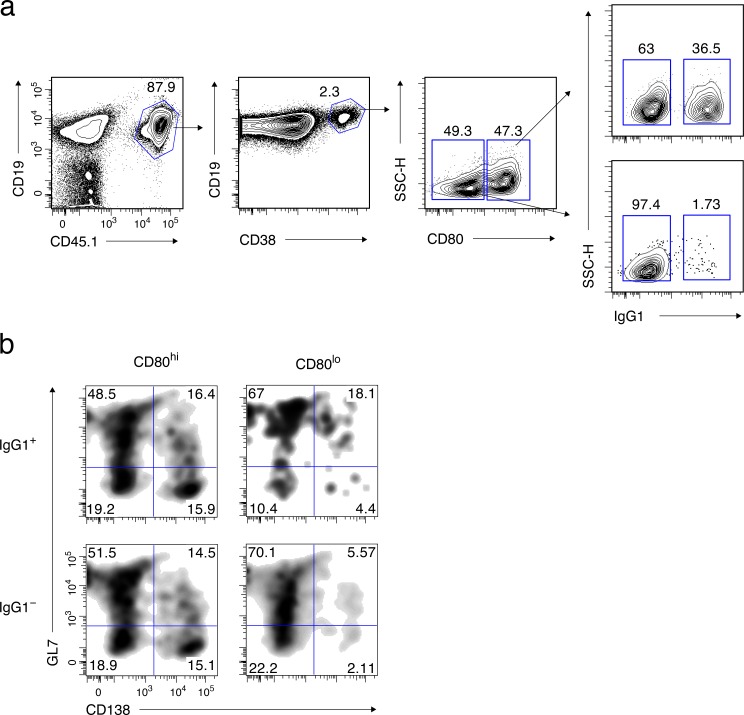
Supplementary data for Figure 1.(a) Sorting strategy for Figure 1b. Splenic B cell from CD45.1 B1-8 ki mice were transferred into B6 mice (CD45.2), which were then immunized with NP-CGG in alum. Four weeks later, donor-derived cells were enriched from pooled splenocytes by magnetic sorting, and further sorted into four Bmem cell subsets, as described in the text. (b) Gating strategy for Figure 1b. Four Bmem subsets, sorted as above, were cultured on 40LB feeder layers with IL-21 for 2 days, and analyzed by FCM. Feeder cells were gated out as CD45.1–cells. The expression of GL7 and CD138 in CD45.1+ cells is shown.